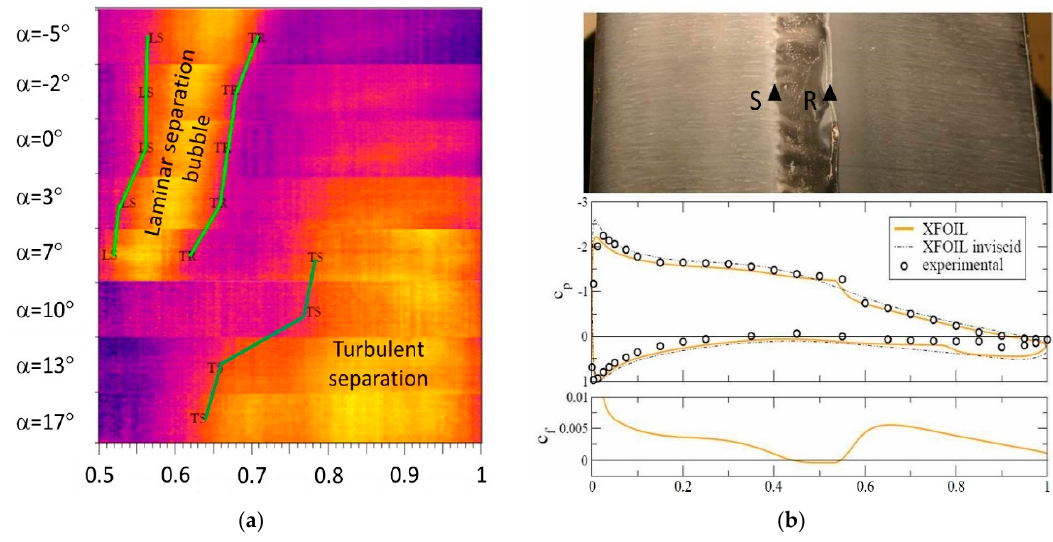
Figure 17. Re = 322,000: ( a ) Infrared imagery (similar temperature scale as in Figure 15) and ( b ) oil-flow visualization, wall pressure coefficient, and skin friction coefficient for α = 6.75 degrees.